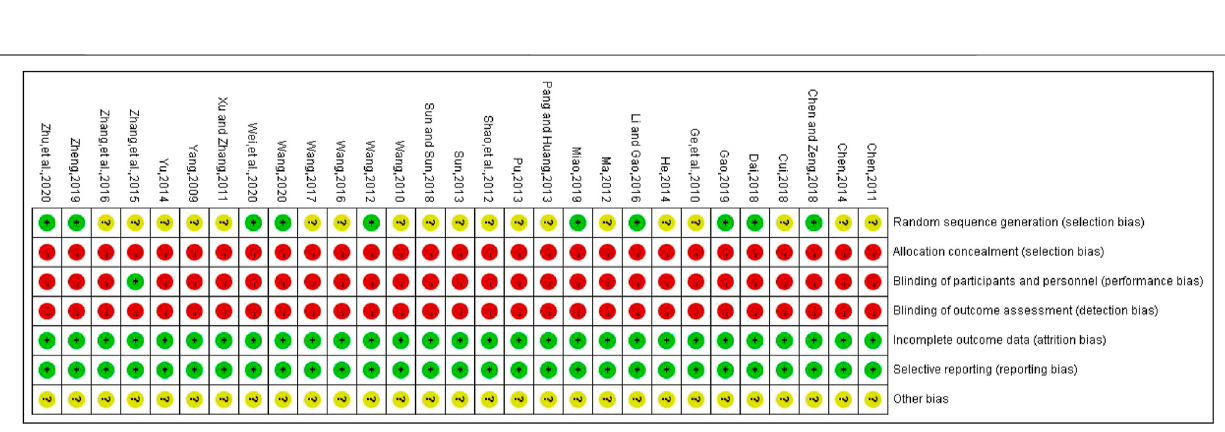
Frontiers in Pharmacology |